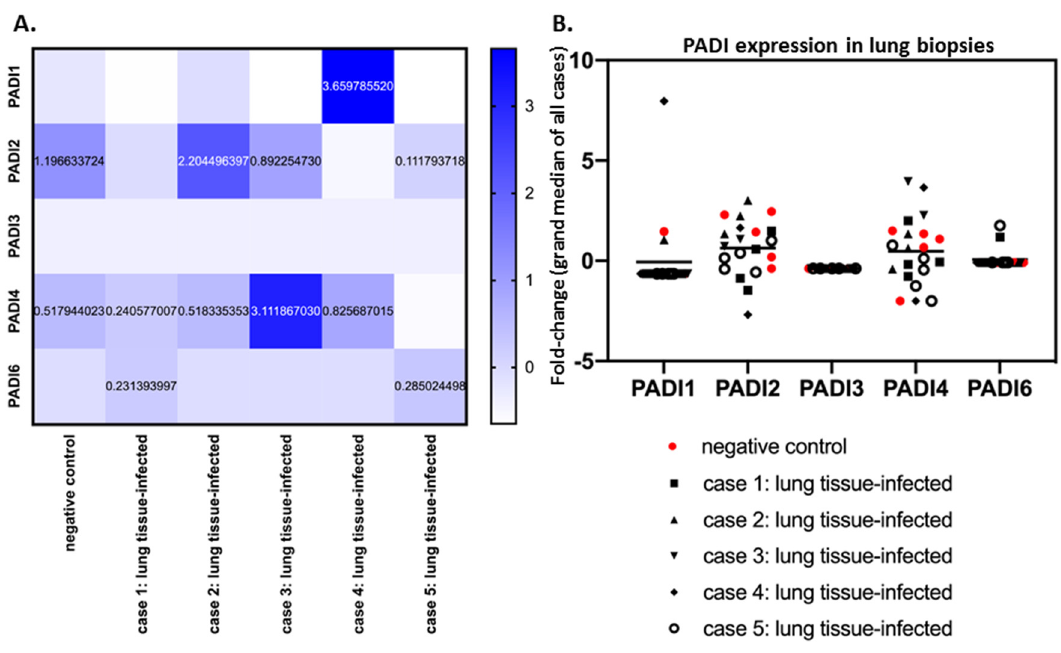
Figure 2. PADI 1-6 isozyme expression levels in SARS-CoV-2-infected lung biopsies, and control lung tissue. ( A ) PRJNA631753 Bioproject data were analysed according to fold change for PADI1, PADI2, PADI3, PADI4 and PADI6 mRNA levels. Average data from control and SARS-CoV-2-infected lung tissue types are presented with a heat map. ( B ) The fold change for mRNA expression levels for each PADI is presented for each case and replicate via grand median distribution of data. Negative control (normal lung samples) and SARS-CoV-2 lung samples were from 5 different cases, with at least 3 replicate biopsy results for lung tissue.